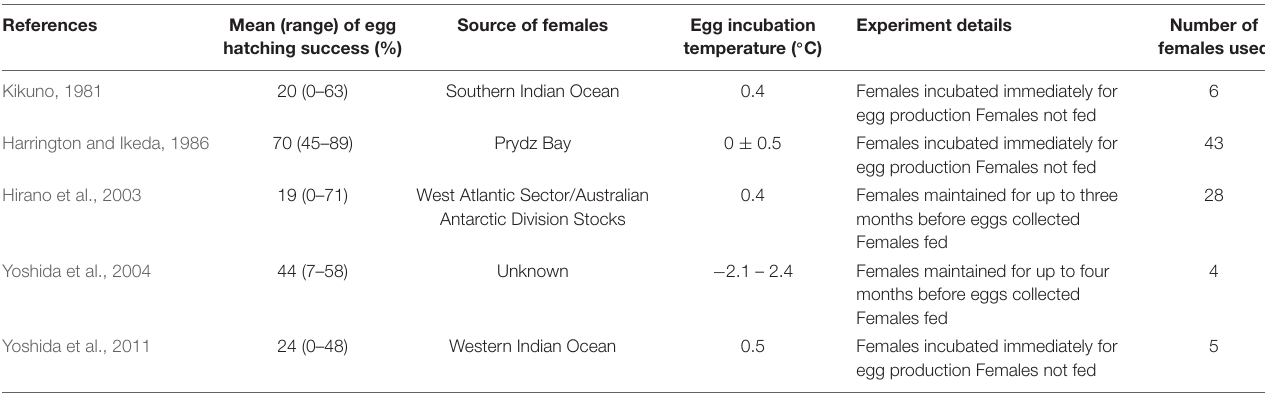
TABLE 2 | Prior hatching success